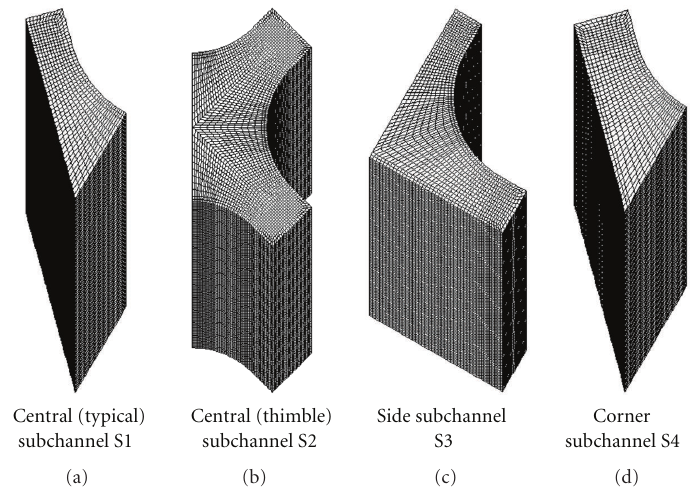
Figure 4: Hexahedral computational mesh.